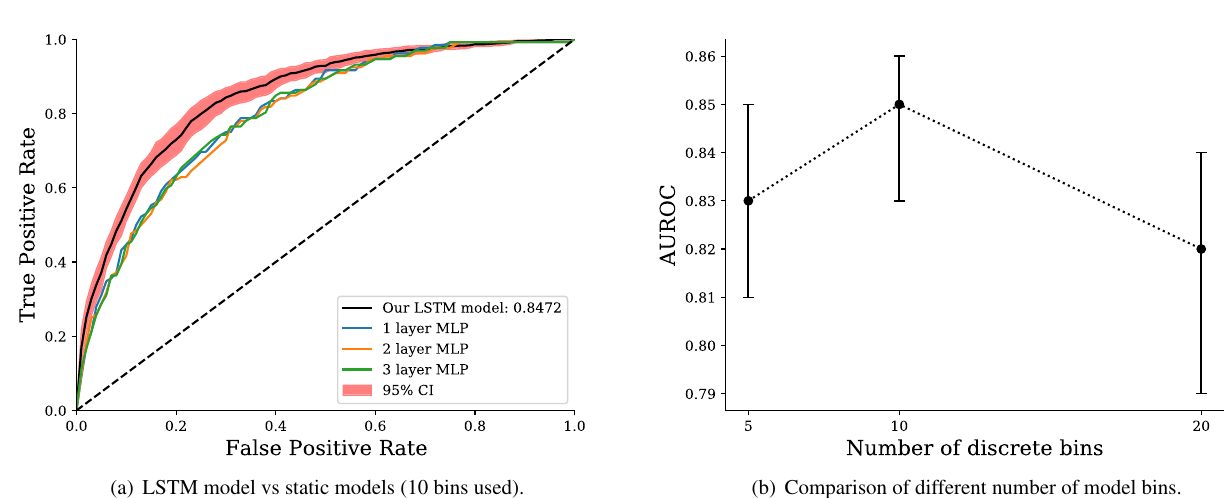
Figure 4. Representative examples of the distribution of blood pH and blood urea nitrogen (BUN) illustrating the effect of discretisation by ‘binning’. In our method, continuous variables are discretised by distribution frequency so that all data types can be handled in the same way in the model. Colours exemplify 5 or 20 discrete categories established by our pipeline for any continuous variable, demonstrating outlier category detection and the increased granularity in populous intervals found by percentile-based quantization. For BUN the distribution is fairly continuous and binning creates a representation which naturally encodes the concepts of ‘high’ or ‘low’ within the distribution. For variables such as pH however, the discretisation also places artefactual values into one ( a ) or more ( b ) ‘outlier’ bins. If artefacts are random, the model should be able to learn that such data points have no predictive value and can therefore be ignored.